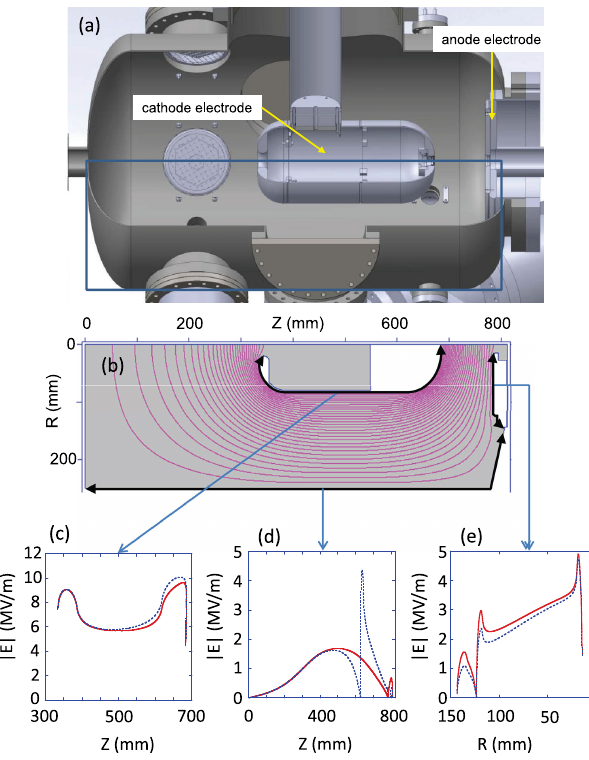
TABLE I. The number of prebreakdown events N and the PB number of interlocked events N during HV conditioning, IL average charge per prebreakdown C and average gas released ave per prebreakdown G for various gun configurations. ave FIG. 7. (a) Cutaway drawing of gun chamber configuration (B) without NEG pumps surrounding the acceleration gap and (b) radial cross section showing calculated static electric field for gun chamber. Surface electric field distributions (red solid lines) (c) of the cathode as a function of Z and of the anode as a function of (d) Z and (e) R at 500 kV. Blue dashed lines show corresponding field distributions with NEG pumps from Fig.